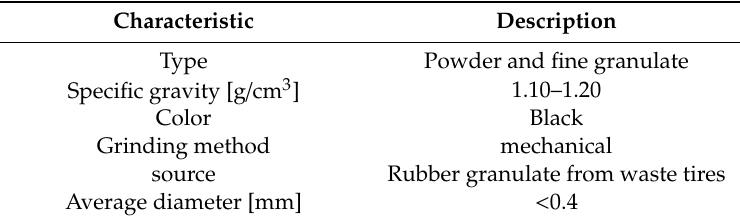
Table 4. Crumb rubber